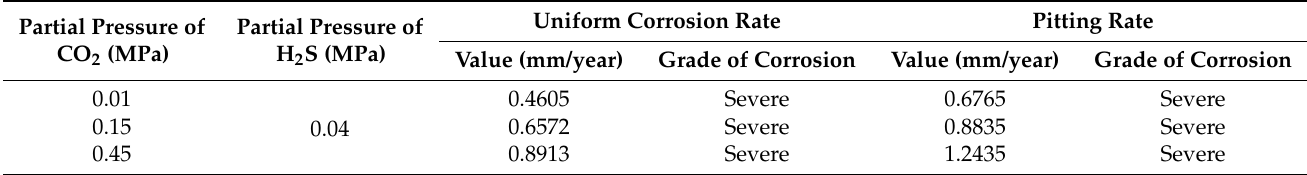
Table 7. Experimental results of the experimental conditions